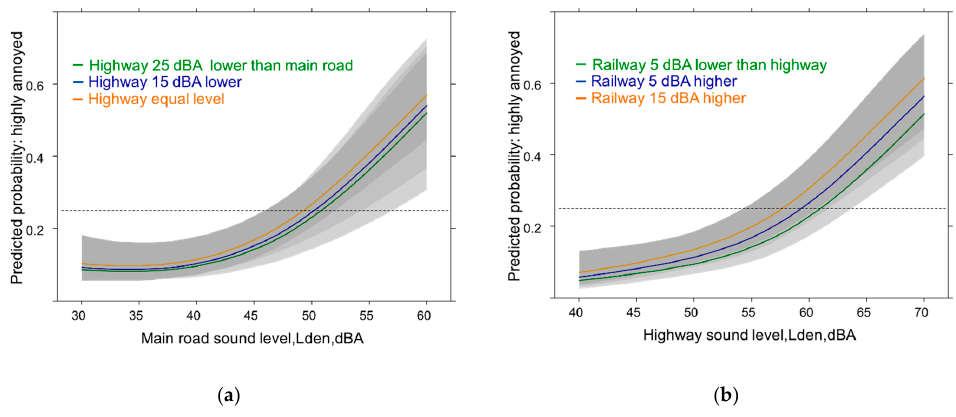
Figure 8. Predicted proportion of high source annoyance associated with level differences to the other source (in dBA). ( a ) Main road & highway; ( b ) Highway & railway. Adjusted for age, sex, education, noise sensitivity, health status and the other sound source difference.